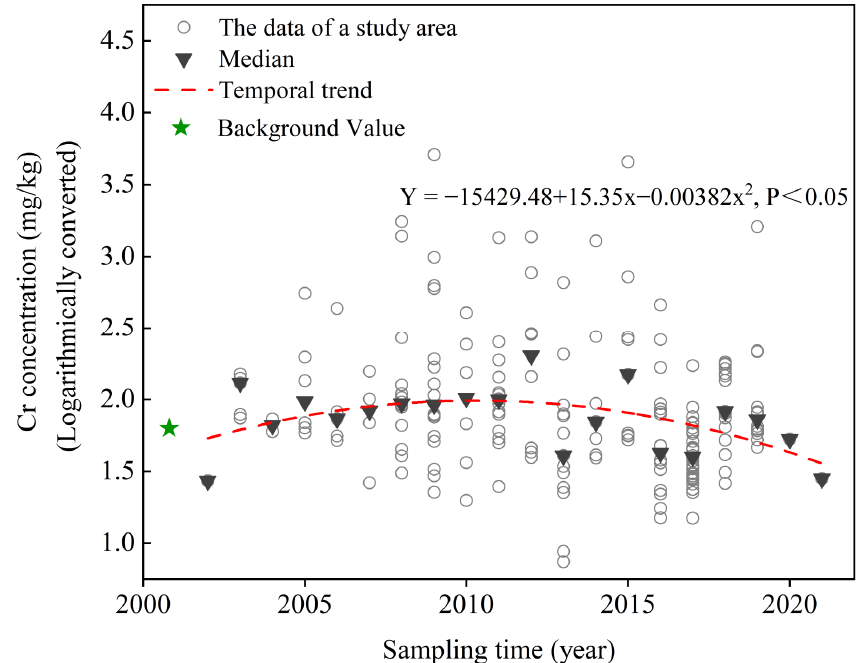
Figure 7. Temporal trend of soil Cr concentrations in industrial regions during 2002–2021.